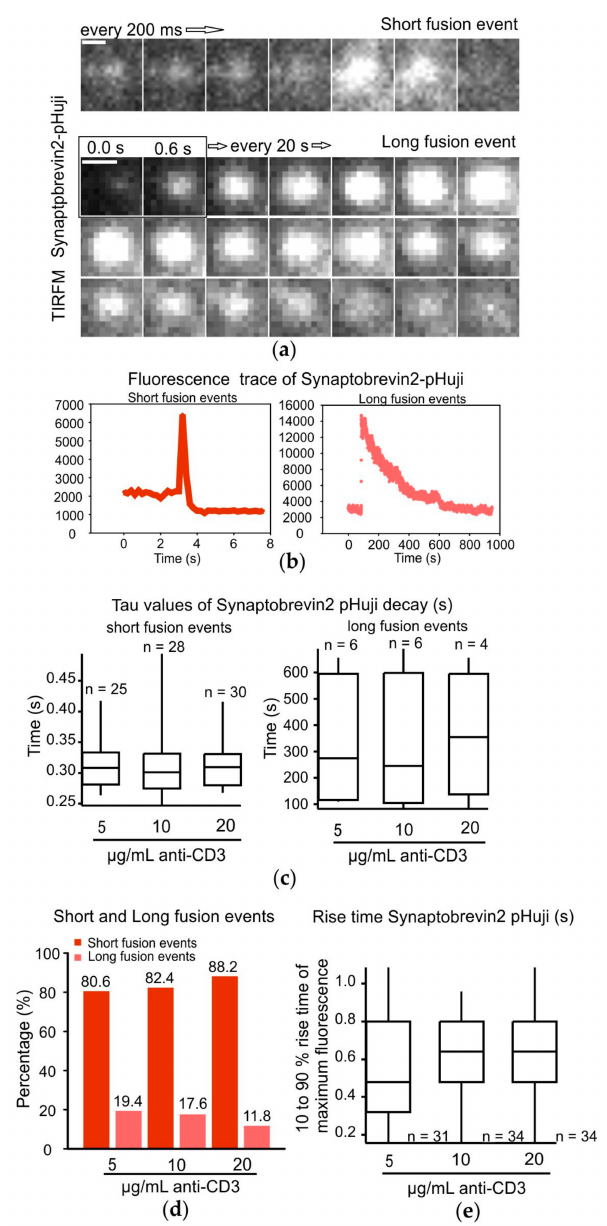
Figure 4. Modes of exocytosis of cytotoxic granules at immune synapses are independent of the strength of the TCR stimulus. ( a ) Exemplary total internal reflection fluorescence microscopy (TIRFM) image snapshots every 0.2 or 20 s unless specified otherwise to visualize Synaptobrevin2-pHuji during short and long cytotoxic granule fusion events, respectively. Scale bars: 1 µ m. ( b ) Exemplary fluorescence intensity time trace analysis of typical short and long fusion events using Synaptobrevin2-pHuji as the fluorescent marker of cytotoxic granules. ( c ) Decay time of Synaptobrevin2-pHuji in the short (left) and long (right) fusion events in CTLs stimulated with 5, 10, or 20 µ g / mL anti-CD3. n = number of fusion events. ( d ) Percentage distribution of short and long fusion events occurring in CTLs when stimulated with 5, 10, or 20 µ g / mL anti-CD3 to induce e ff ector immune synapses. ( e ) Rise time of Synaptobrevin2-pHuji in the short and long fusion events in CTLs stimulated with 5, 10, or 20 µ g / mL